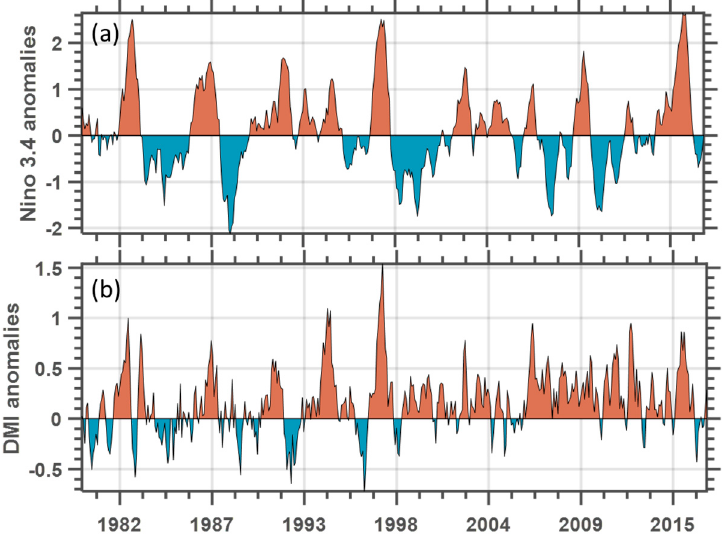
Figure 2. The standardized monthly Niño3.4 ( a ) and dipole mode index (DMI) ( b ) time series for the period from 1980 to 2017.